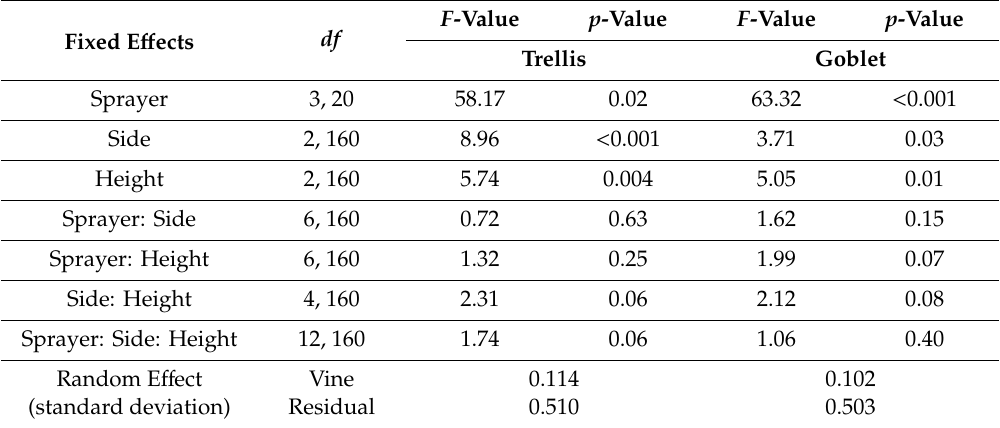
Table 3. Results of the linear mixed-e ff ects model for the e ff ect of the sprayer, side, and height on d N on leaves for the trellis and goblet training systems.